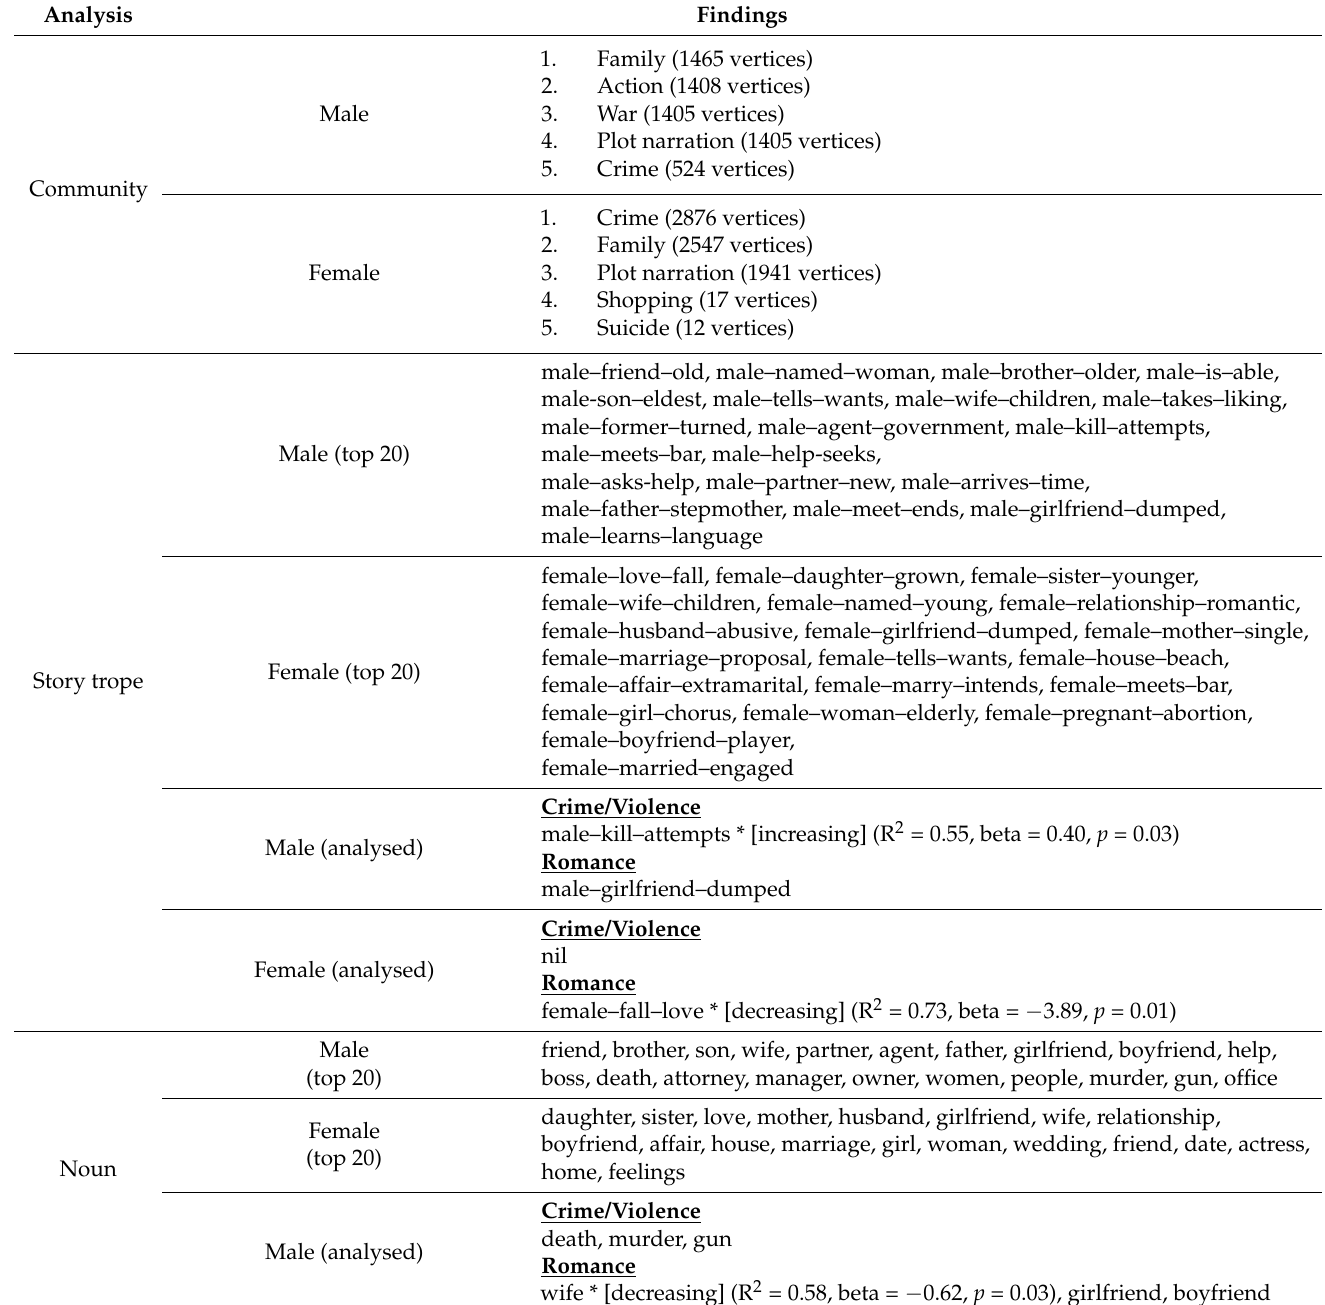
Table 6. Summary of quantitative results from different types of analysis conducted. ** p < 0.01, * p < 0.05, + p <